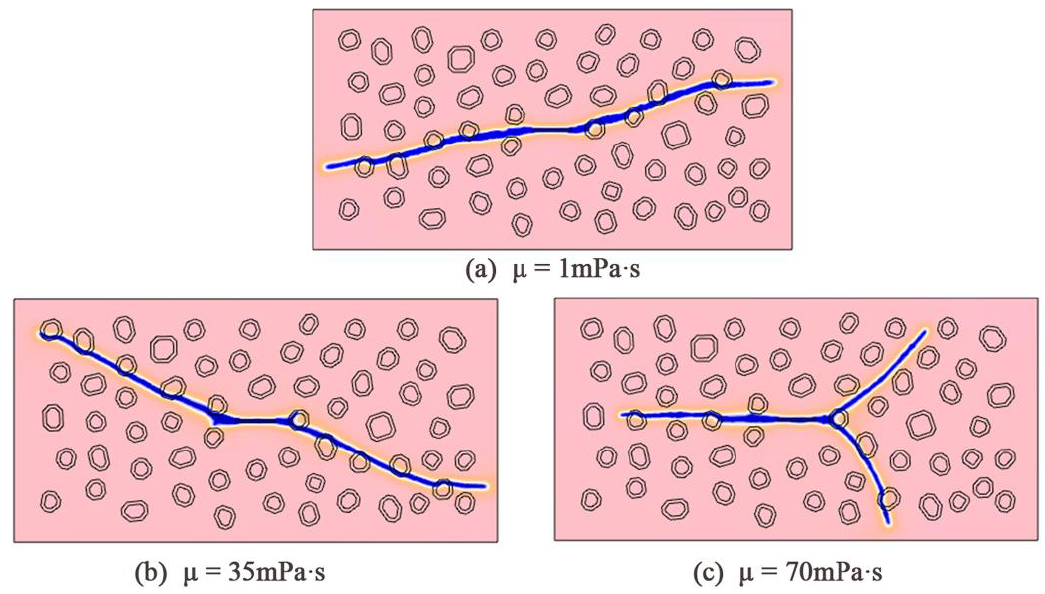
Figure 8. Fracture propagation under different fracturing fluid viscosities. ( a ) µ = 1 mPa · s; ( b ) µ = 35 mPa · s; ( c ) µ = 70 mPa · s.